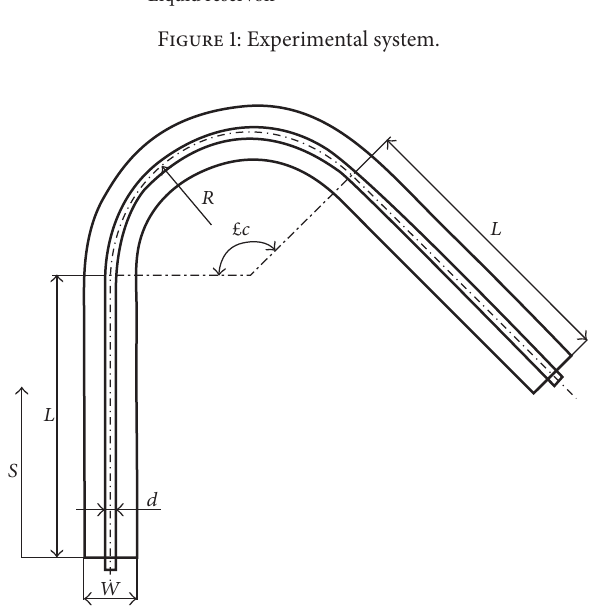
Figure 2: Schematic of the experimental